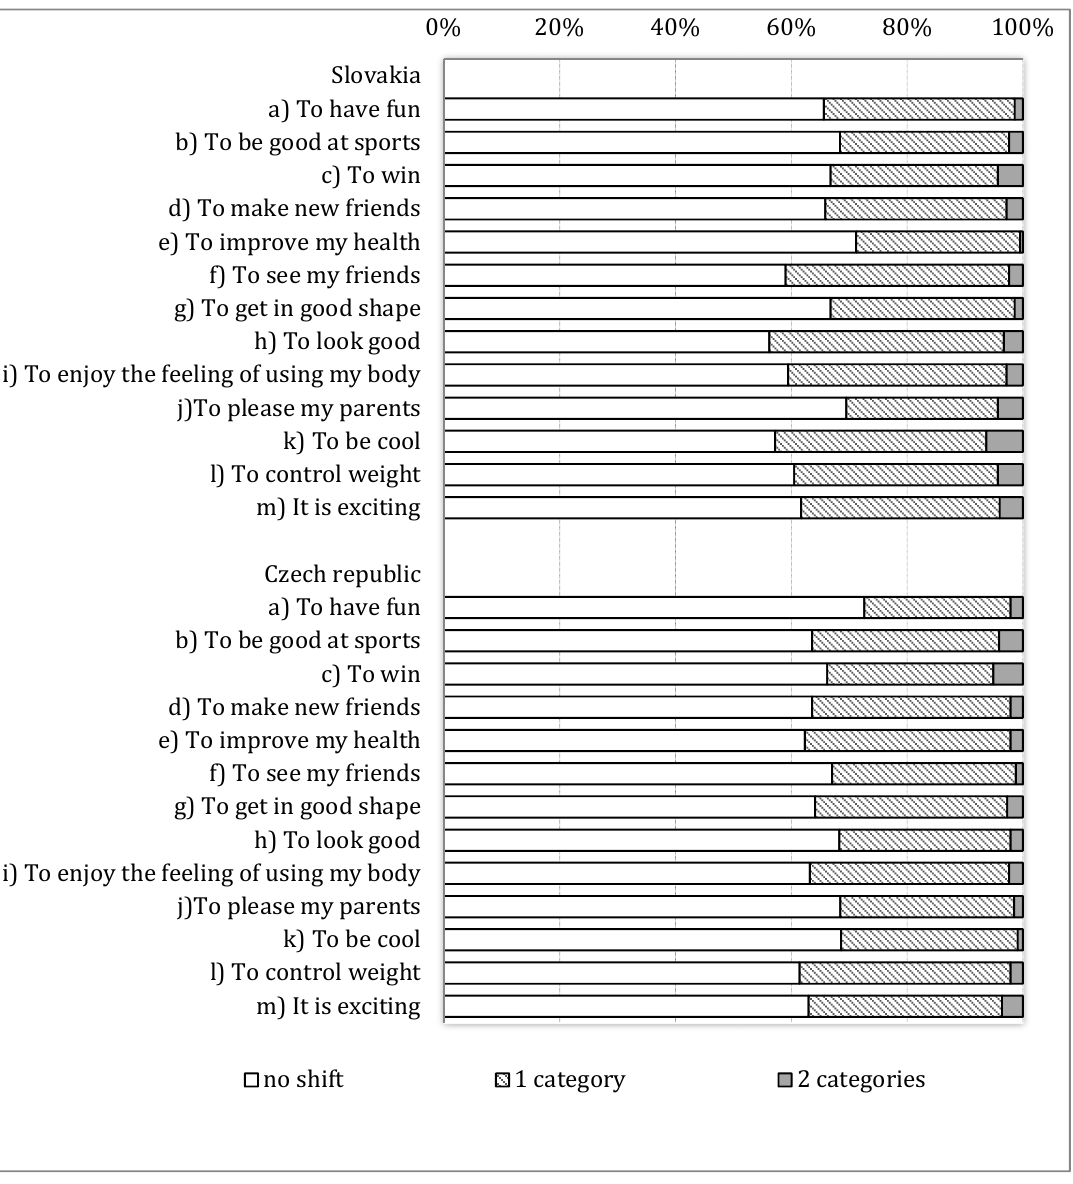
Figure 1. Percentage of test–retest response shifts in motives for physical activity items counted separately for Slovakia and Czech Republic.